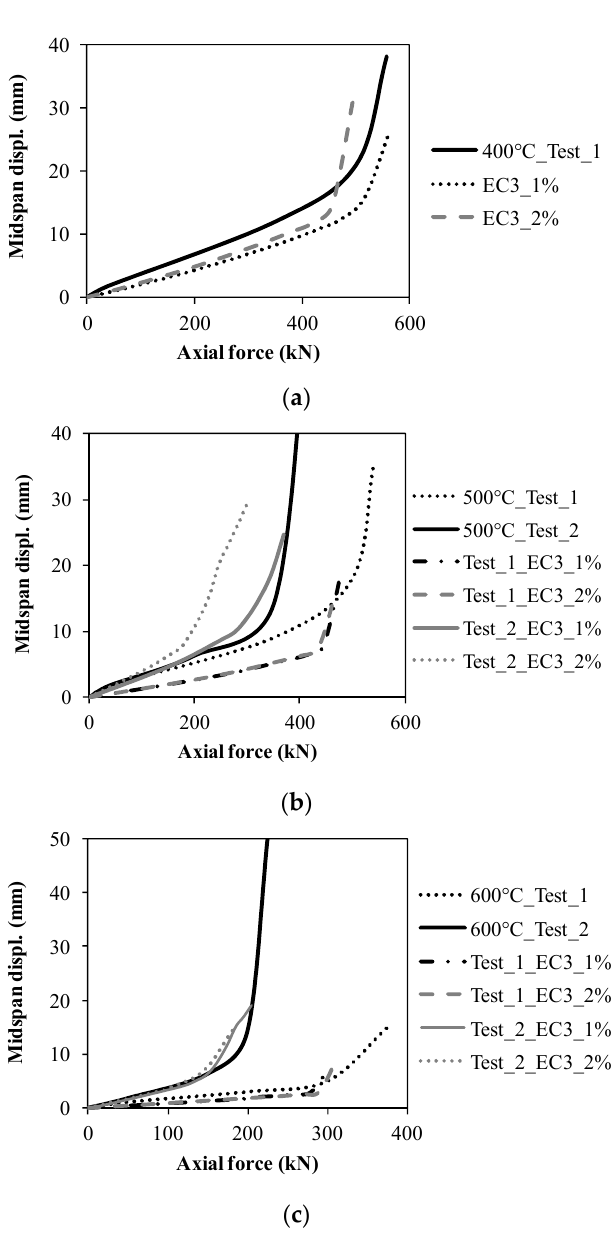
Figure 4. Results of column capacity tests and comparison with the Vulcan model: ( a ) 400 °C; ( b ) 500 °C; and ( c ) 600 °C.